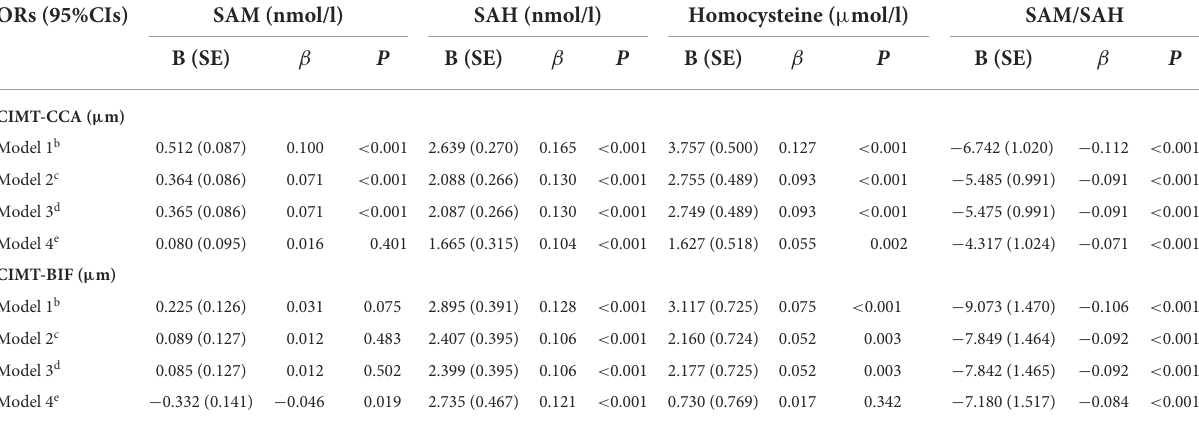
TABLE 4 Multivariable linear regression on the associations of C1 metabolites of the methionine cycle and carotid intima-media thickness, Guangzhou Nutrition and Health Cohort ( n = 2,991) a . ORs